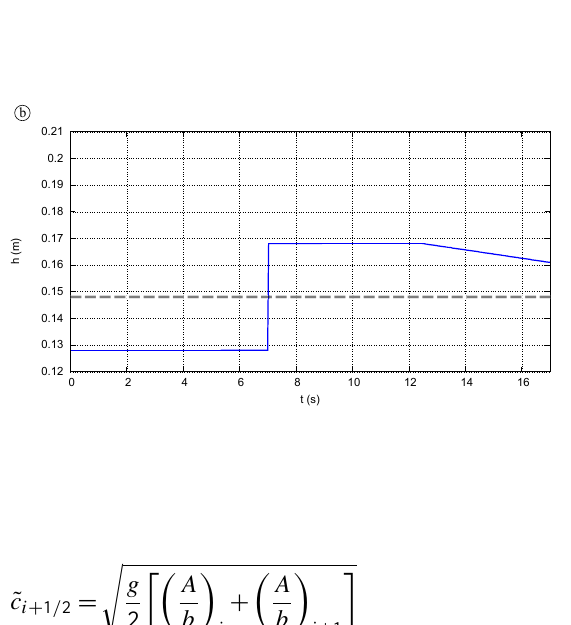
Figure 7. Upstream (a) and downstream (b) pressured head level.